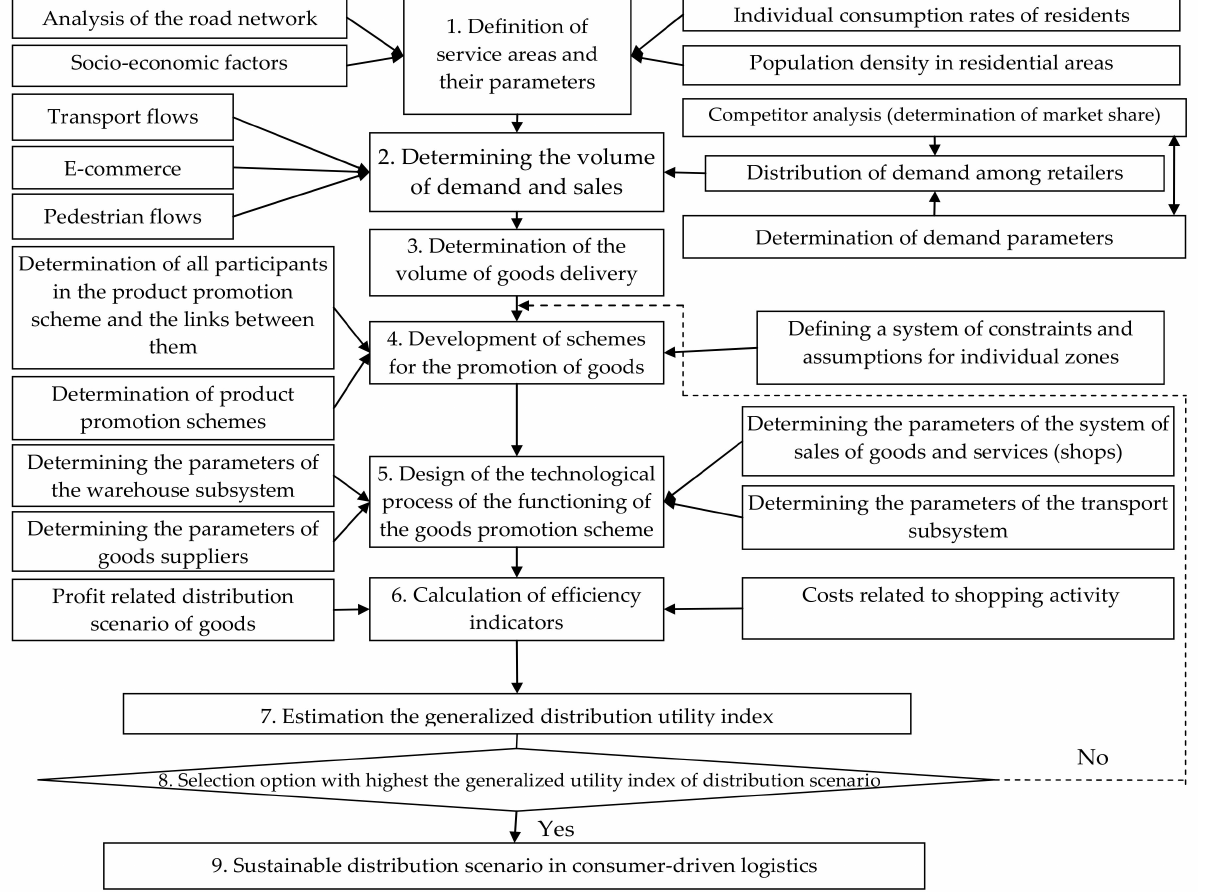
Figure 2. Stages of sustainable distribution in consumer-driven